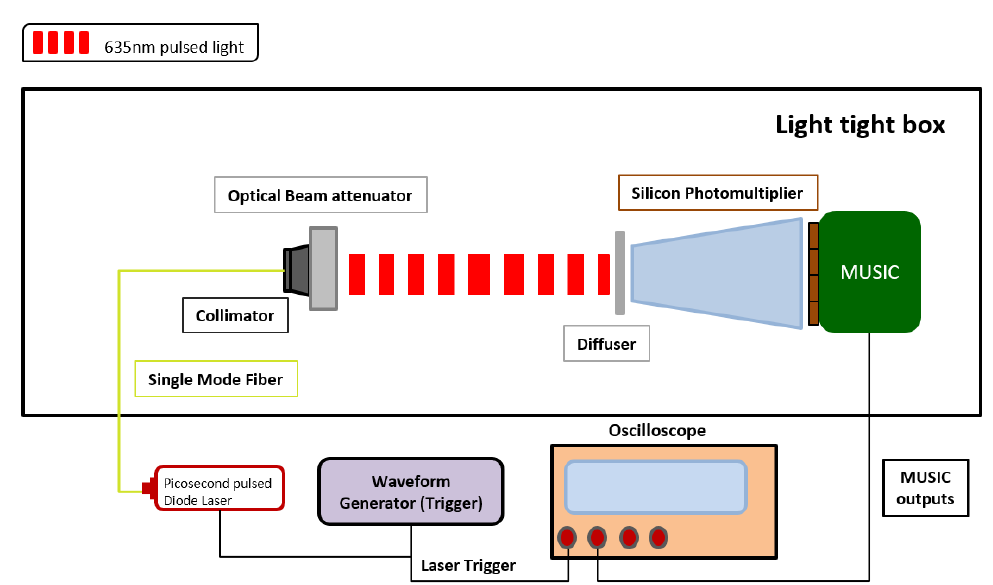
Figure 9. Schematic representation of the experimental setup using a red laser source for charge and single-photon time resolution (SPTR) measurements.